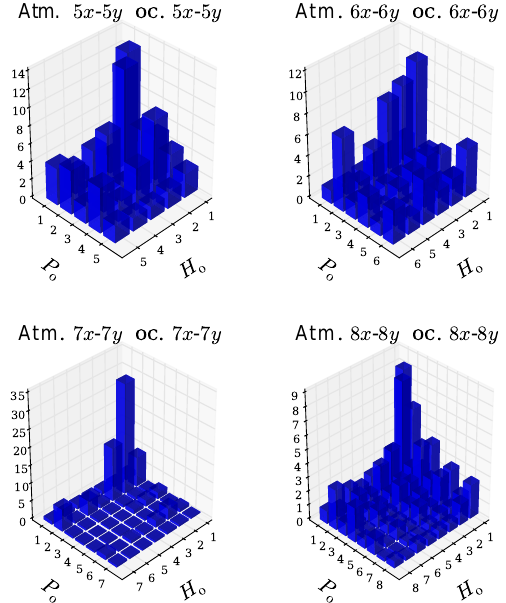
Figure 5. Variance distributions of the ψ o ,i variables in percents for various model resolutions.